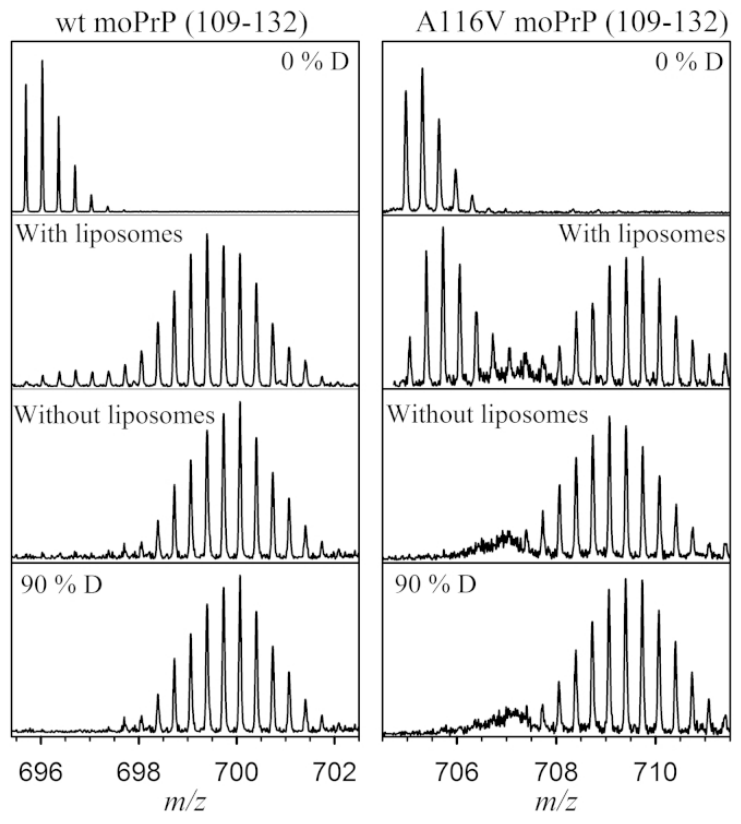
Figure 5. The peptide spanning 109–132 in WT and A116V moPrP displays a significant decrease in deuterium uptake in the presence of liposomes. At 30 s of deuterium labeling, there is a bimodal distribution in the presence of liposomes, compared with the unimodal distribution seen in the absence of liposomes. The controls of protonated (0% D) and deuterated (90% D) peptide fragments are also shown. Reproduced with permission from the Biophysical Society (© 2016).